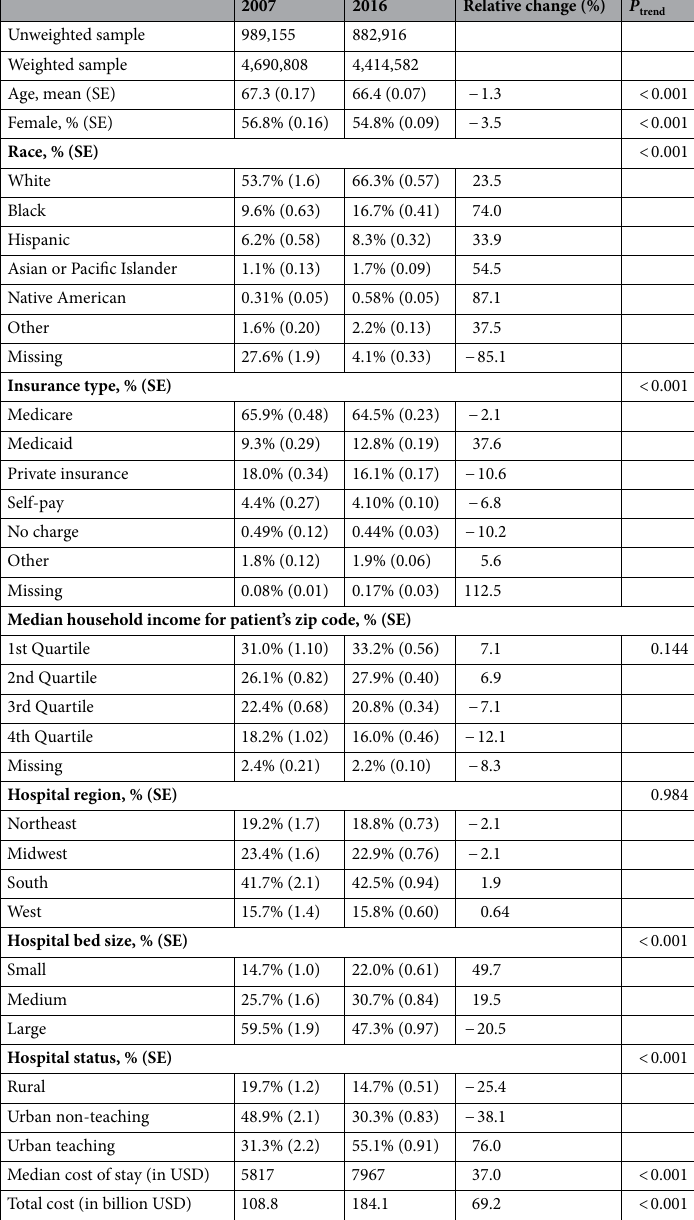
Table 1. Trends in demographic, hospital and clinical characteristics, 2007–2016. SE standard